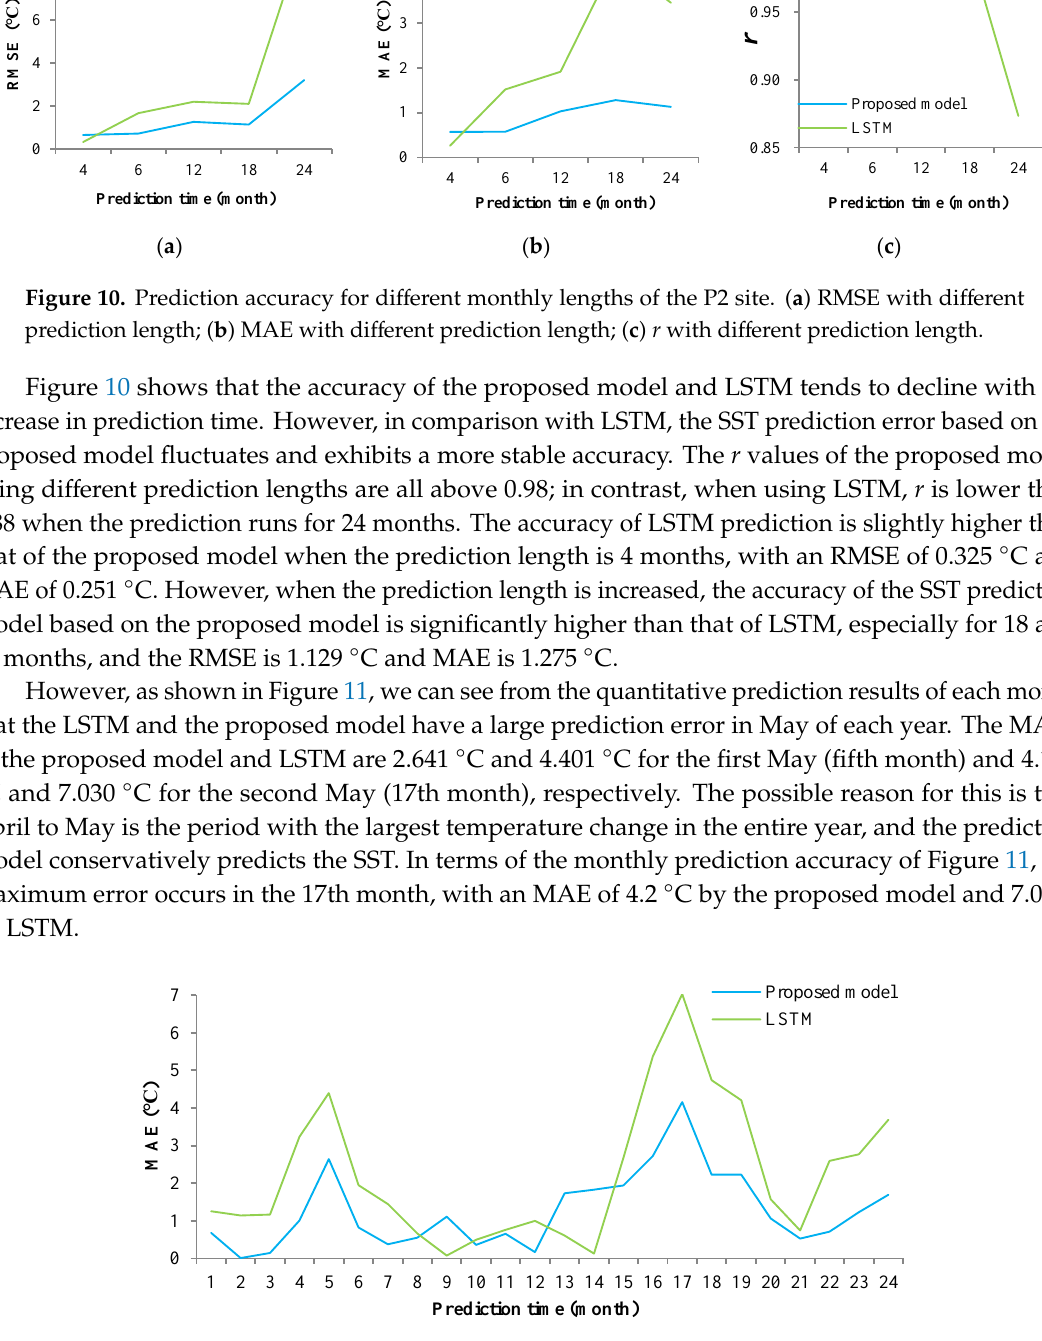
Table 2. Monthly RMSE and MAE of six sites with different predicted lengths (the unit is °C).